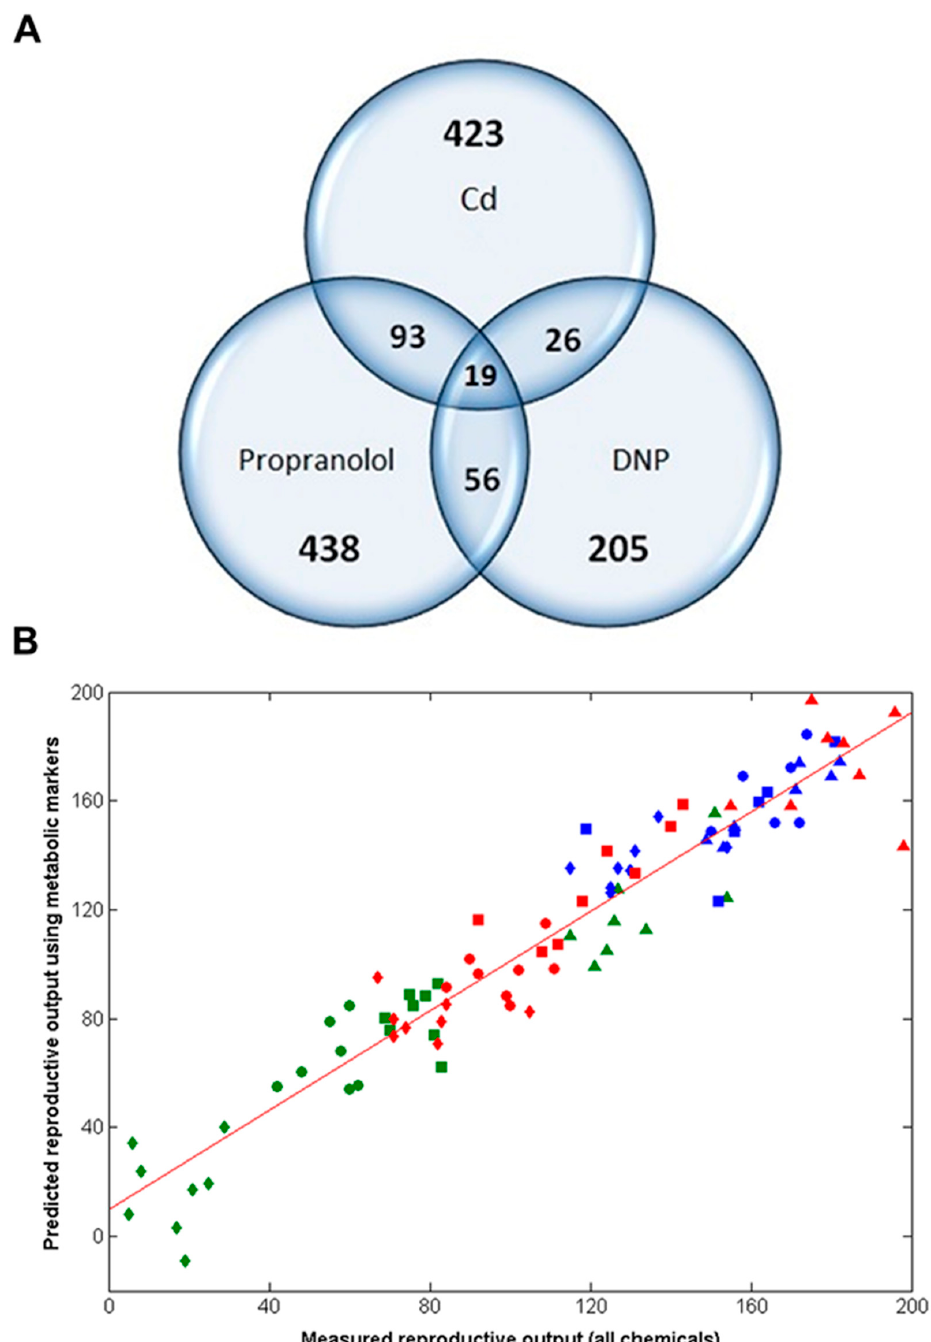
Figure 4. ( A ) Venn diagram depicting the relationship between the metabolic features (i.e., peaks) from each of the optimal PLS-R models following chronic exposure of Daphnia to Cd, DNP or propranolol; ( B ) Correlation between measured and predicted reproductive output for individual D. magna, the latter derived from the non-chemical-specific forward selected PLS-R model, following chronic exposure to Cd, DNP and propranolol, including line of best fit. The cross-validated R 2 value is 0.915 (49 peaks, 3LVs); p = < 0.001. Classes comprise of Cd exposed animals: control ( ), low ( ), medium ( ) and high dose ( ); DNP exposed: control ( ), low ( ), medium ( ) and high dose ( ); propranolol exposed: control ( ), low ( ), medium ( ) and high dose ( ).